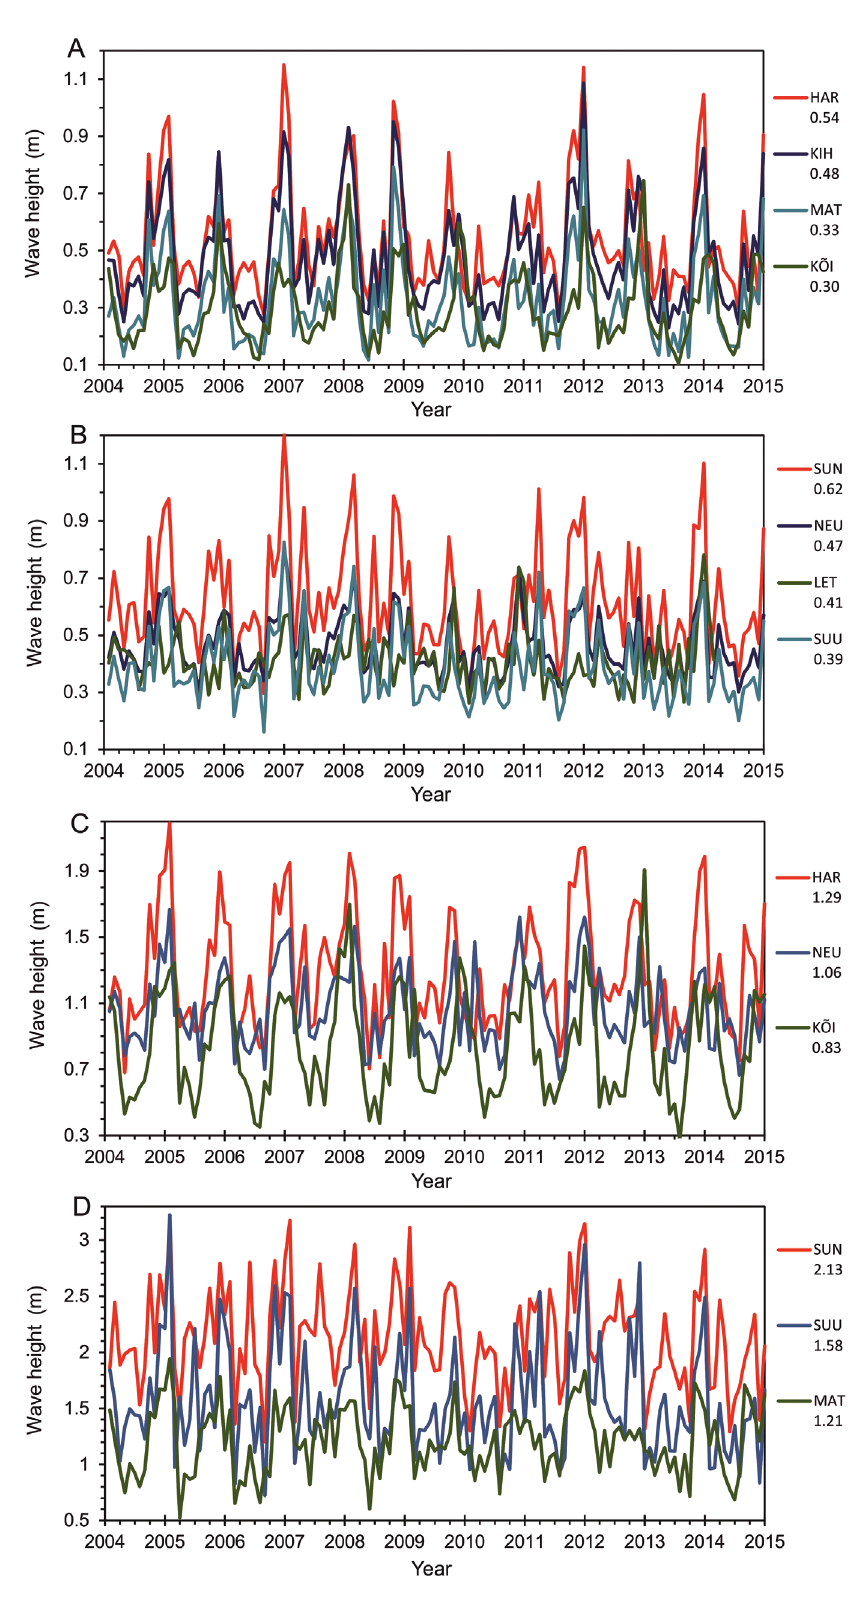
Fig. 4. Average wave